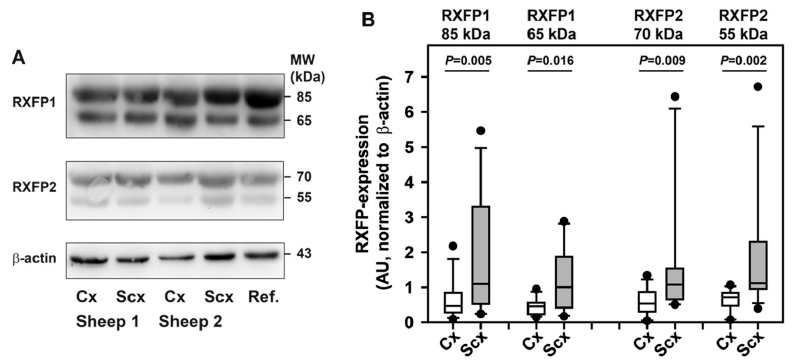
Figure 9. Expression of relaxin receptors in brain vessels. Western blot analysis was performed for cortical and subcortical brain vessels. ( A ) Both RXFP1 and RXFP2 consistently presented as double bands in the cortex and subcortex; data for two sheep are shown. ( B ) Quantitation of receptor expression after normalization of band intensities to the housekeeping protein β -actin showed higher expression levels for all detected bands in the subcortex than in the cortex. As these data were not normally distributed, they are presented as box plots (boxes represent 25th–75th percentile, with medians indicated by a horizontal line). Whiskers indicate the 10th and 90th percentiles, respectively. Dots indicate outliers. Differences were identified with the Wilcoxon signed rank test, N = 12 sheep. Cx, cortical vessels; Scx, subcortical vessels; AU, arbitrary units; Ref., reference sample.